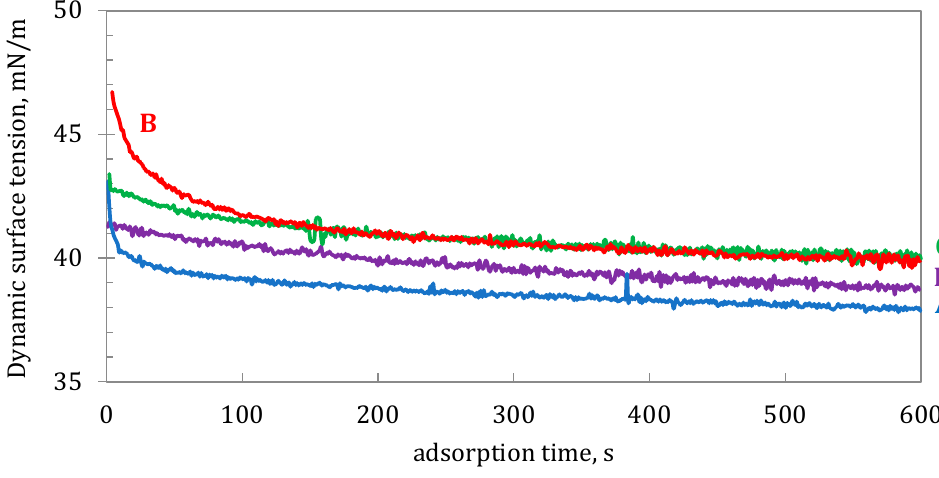
Figure 7. Dynamic surface tension, σ d , of BUD suspensions A, B, C, and D (25 ± 0.5 ° C).